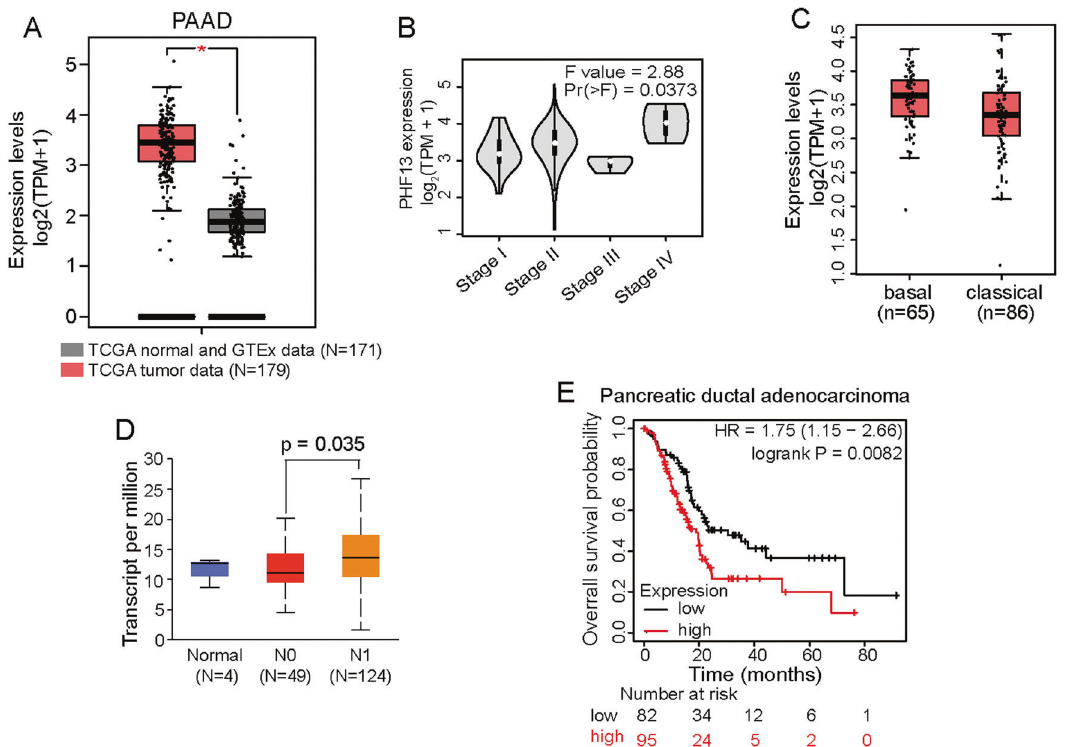
Fig. 1 High expression of PHF13 is associated with human cancer. A Boxplot showing TPM-normalized expression of PHF13 in normal tissues and pancreatic adenocarcinoma (PAAD). The results were generated by the online tool: GEPIA [73]. Given that there are only 4 normal pancreatic samples in TCGA data, we combined them with the pancreatic samples in GTEx data. B Violin plot showing the expression of PHF13 at different clinical stages in patients with PAAD. The data was generated using the GEPIA tool [73]. C Boxplot comparing the TPM-normalized expression of PHF13 between basal-like and classical subtypes. The data was generated using the GEPIA2 tool [73]. D Boxplot showing normalized expression of PHF13 in normal pancreatic tissues (Normal), pancreatic tumors with no regional lymph node metastasis (N0), and pancreatic tumors with metastases in 1 to 3 axillary lymph nodes (N1) in the TCGA cohort. N number of patients. The result was generated from the online tool UALCAN [74]. E Kaplan – Meier plot showing the overall survival of patients based on PHF13 expression. Data is generated from the webserver (http://kmplot.com/analysis/) [75]. HR hazard ratio, CI con fi dence